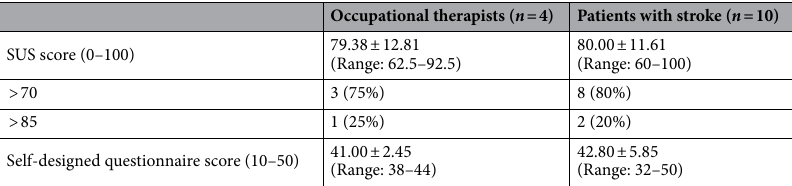
Table 3. Usability of the multi-mode stroke rehabilitation system in patients with stroke and occupational therapists. The listed statistics are presented as mean ± standard deviation (SD) or frequency (percentage) as appropriate for the data type. Abbreviations: SUS, System Usability Scale. Note: Higher SUS scores are indicative of greater usability. Higher scores of the self-designed questionnaire are indicative of better user experiences.